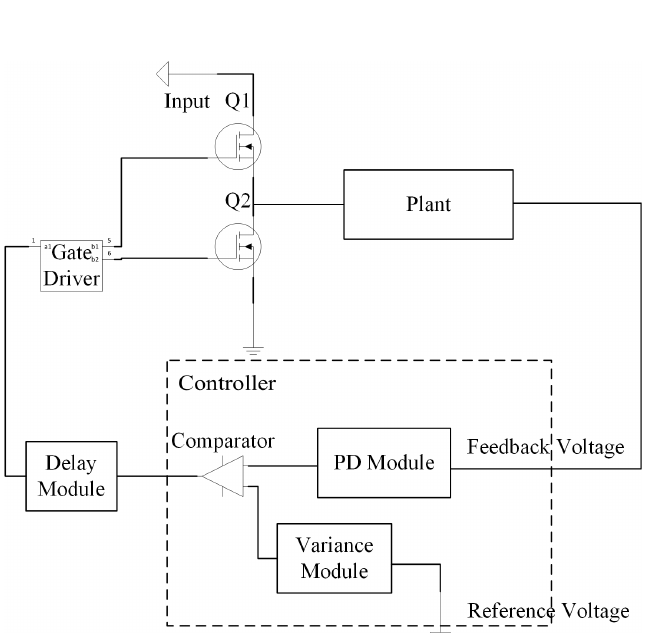
Figure 4. The block diagram of Algorithm